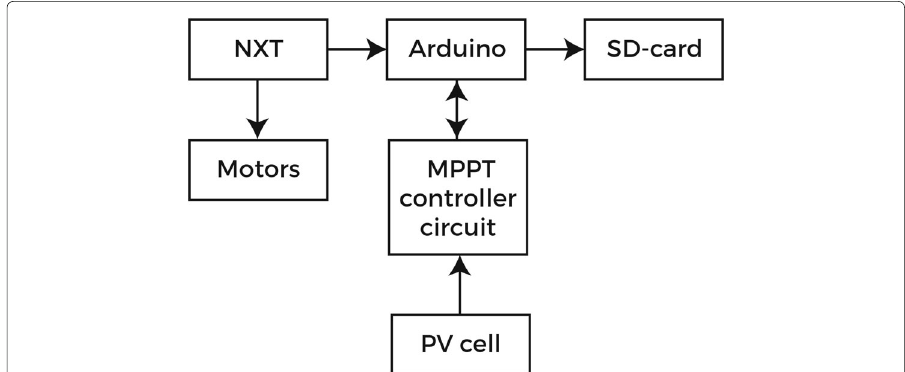
The system’s control components are the LEGO NXT Brick and an Arduino. The NXT master controls the motors and the Arduino, while the Arduino slave controls the MPPT controller and the logging module. Two LEGO servo motors are powered and controlled over a 9.6 mm non-standard RJ (Registered Jack) with displaced snap-in nose. A unidi- rectional I2C connection is used to send commands from NXT to Arduino. One of the Arduino’s PWM output pins serves as the control input to the the MPPT controller. The PWM signal is used as the gate control of a transistor, which controls the PV cell’s current as well as its voltage. The full range of possible load impedances is explored to find the maximum power point. A logging module is used by the Arduino for write-only access to the log files on the microSD-card. A schematic overview over the system is depicted in Fig. 4. The sweep routine iterates through all possible configurations for the (α , θ) tuple of angles, where α is the elevation angle and θ is the azimuth angle. The solar angles are measured tangential to the earth’s surface. The elevation is the vertical solar angle and the azimuth is the horizontal solar angle, as is shown in Fig. 5. The procedure initializes α with 0 ◦ , which sets the elevation angle to the lowest orientation. The θ is initialized as -90 ◦ , so that the sweep starts with an orientation towards East. While the upper limits of both angles are not reached, they are both increased in a double loop. The inner loop